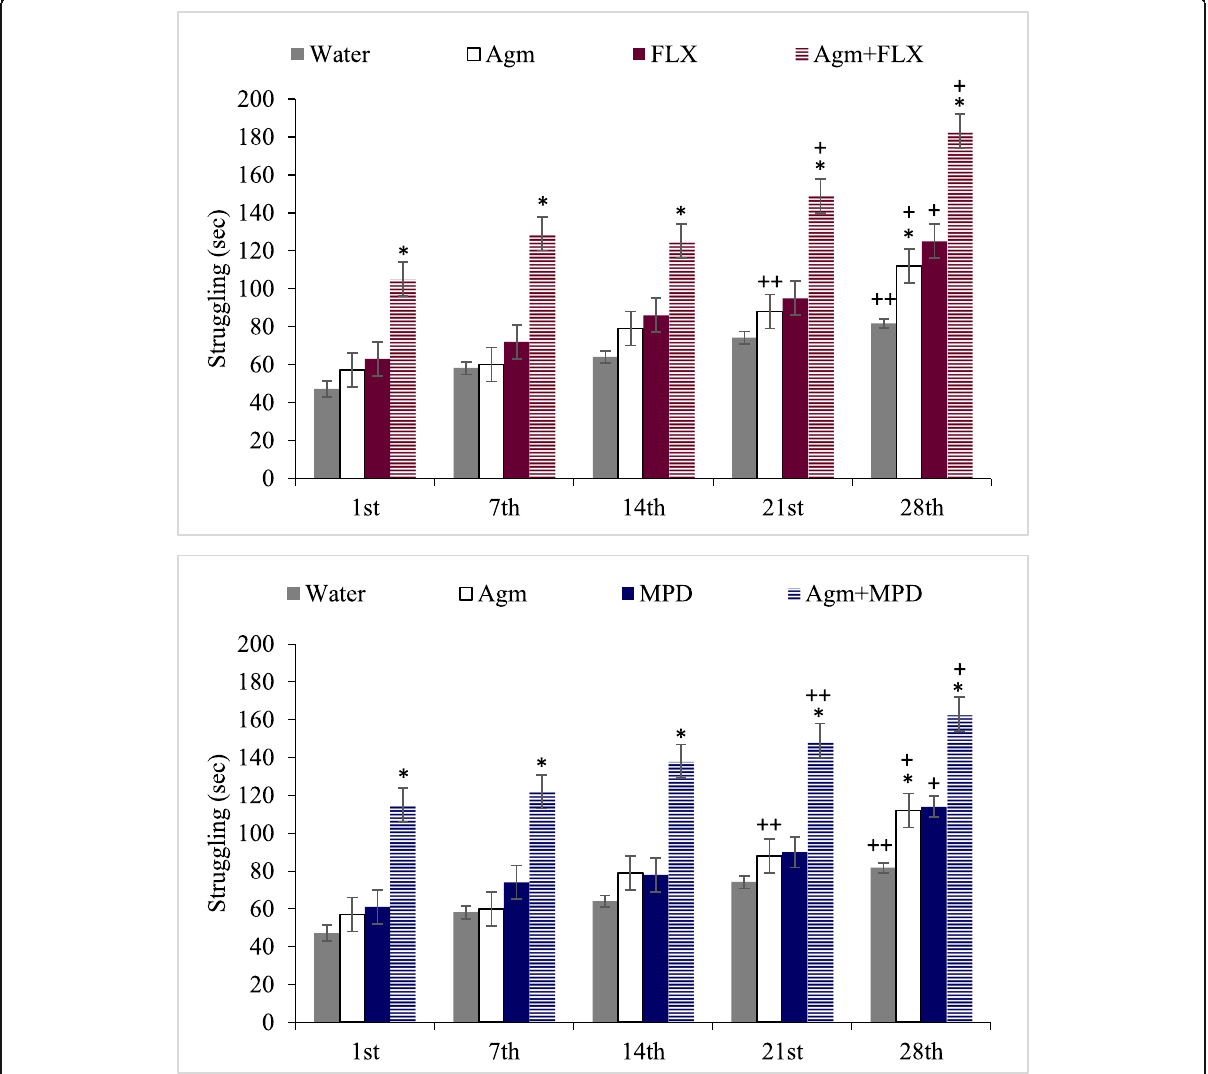
Fig. 8 FST: values are expressed as means ± SD ( n =6). Significant differences by Newman-Keuls test: * p <0.01, ** p <0.05 from water-treated control group to drug-treated groups. + p <0.01, ++ p <0.05 from drug ’ s 1st administration. # p <0.01, ## p <0.05 from AGM-treated animals to FLX- and